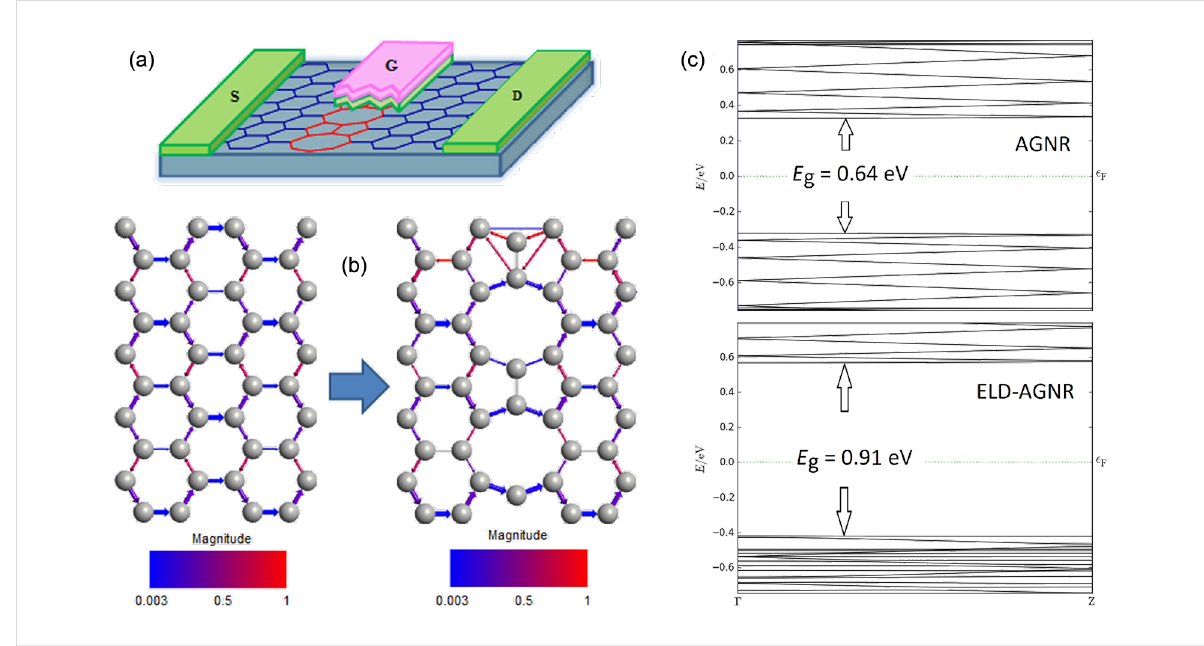
Figure 1: (a) Schematic sketch of a simulated GNRFET with an extended line defect in the center of the channel, N-type contacts, Al 2 O 3 gate dielec- tric and SiO 2 substrate. (b) Transmission pathway along 1.8 × 20 nm armchair graphene nanoribbon. The arrows show the magnitude of carrier trans- port. (c) Band structure of 1.8 × 20 nm AGNR (top image) and ELD-AGNR (bottom